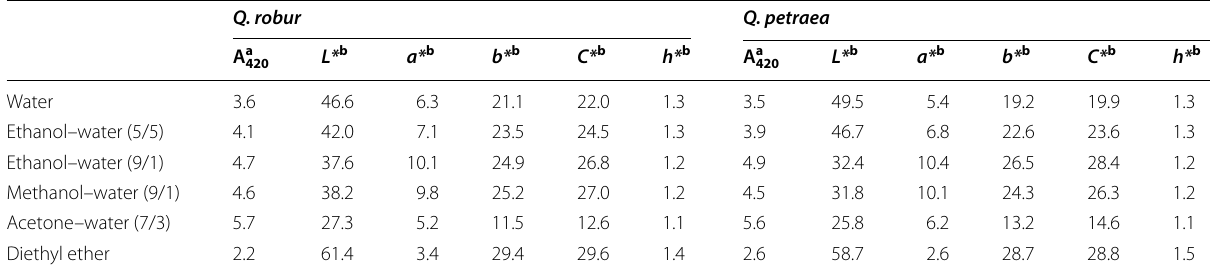
Table 1 Colour parameters of Q. robur and Q. petraea heartwood extracts. Incidence of different solvents or mixtures of